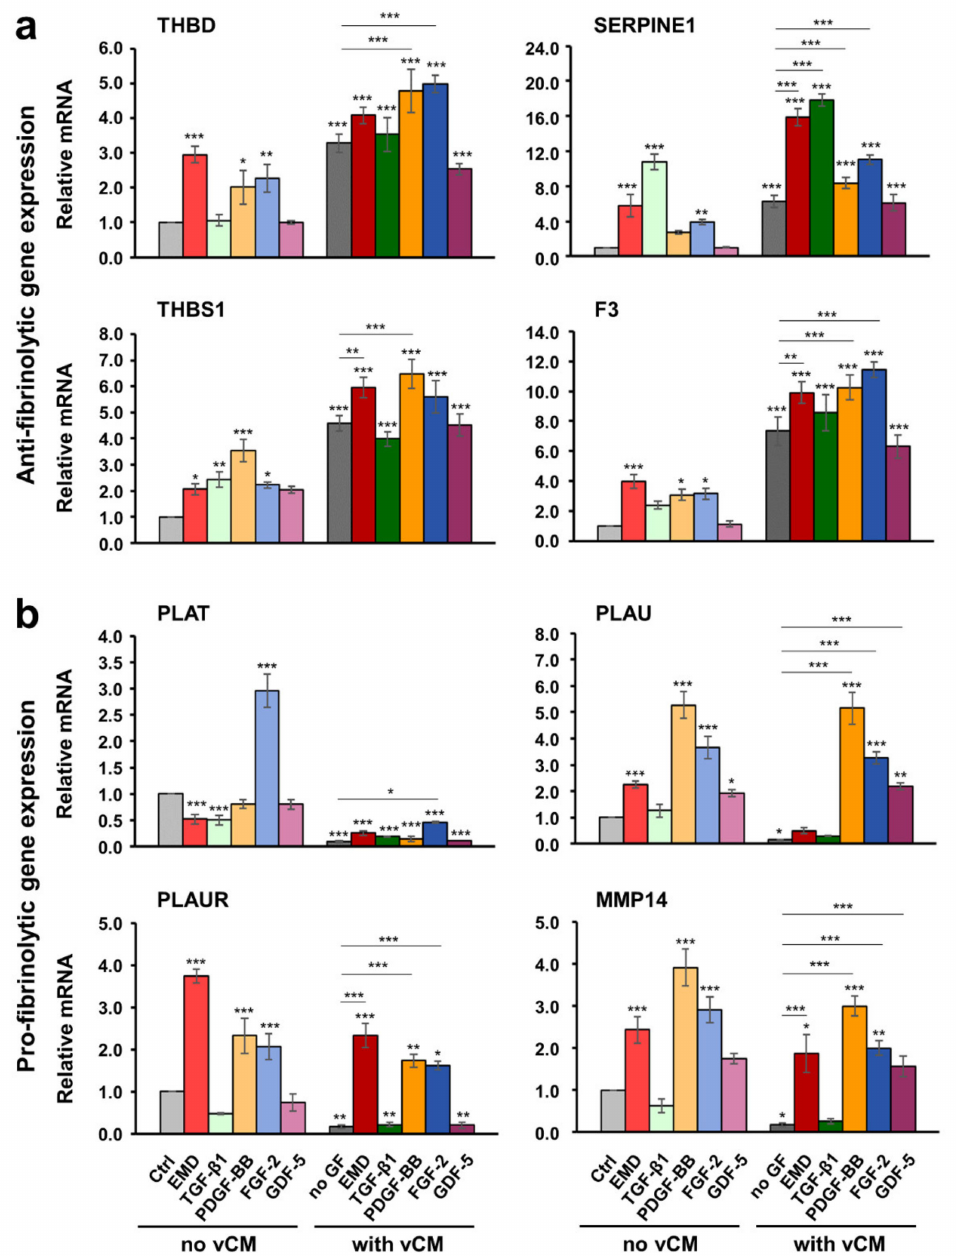
Figure 5. Effect of native/uncoated or growth factor-coated vCM on the anti- ( a ) and pro- fibrinolytic ( b ) gene expression in primary hOFs. Cells were grown under each of the four experimental conditions described in Figure 3 before total RNA was extracted and analyzed by qRT-PCR for the expression of THBD, SERPINE1, THBS1, and F3 antifibrinolytic ( a ) as well as PLAT, PLAU, PLAUR, and MMP14 profibrinolytic ( b ) genes. Values normalized to GAPDH are expressed relative to the values of control cells (Ctrl) grown as described in Figure 3a. Means ± SD from three independent experiments and significant differences to the Ctrl unless otherwise indicated, *** p < 0.001, ** p < 0.01, * p < 0.05 are